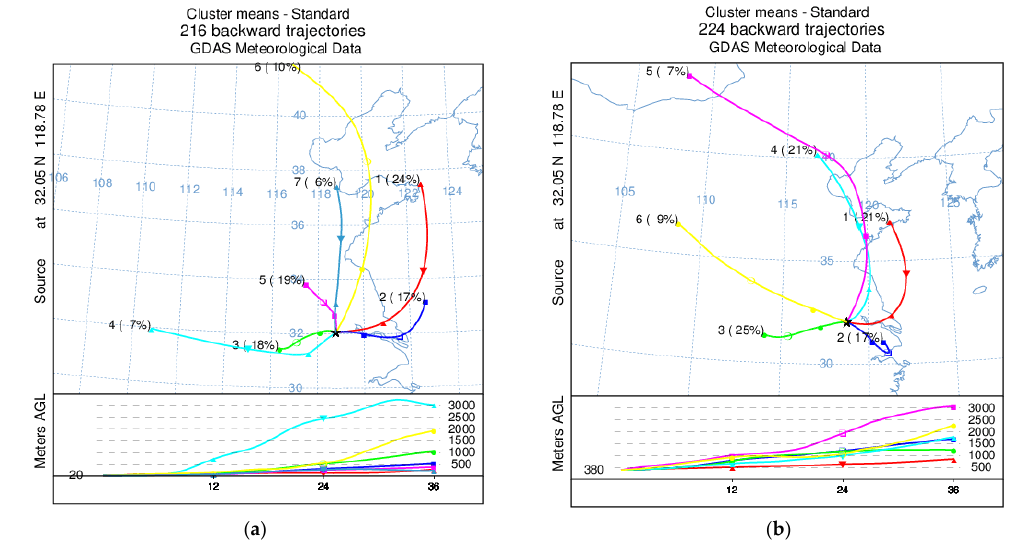
Figure 8. Clustering analysis every three hours for the sampling periods at ( a ) 20 m and ( b ) 380